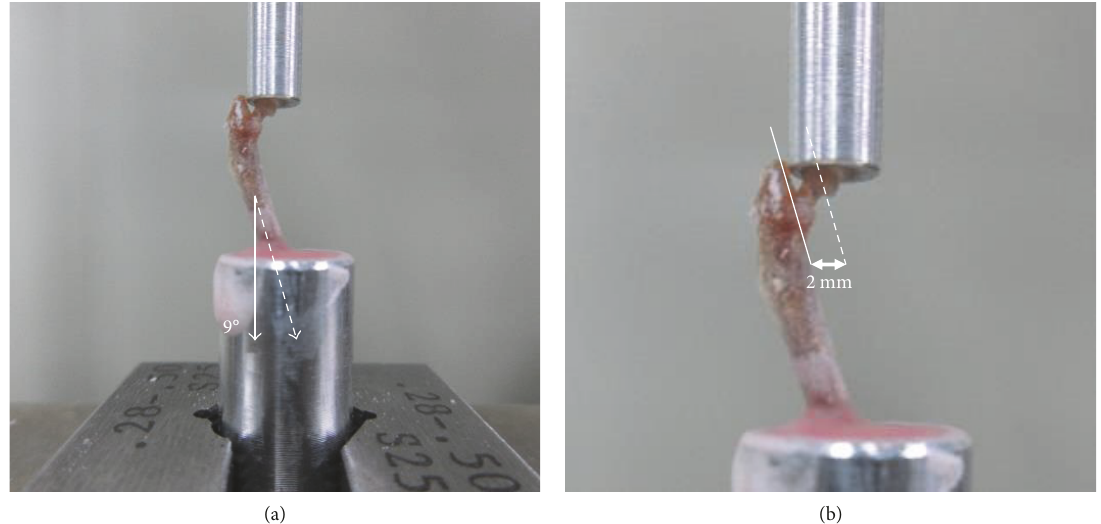
Figure 2: Setup of the femoral head compression test. (a) The femur was potted in a cylindrical lower jig at a 9 ° angle. (b) The gage length is the distance from the center point of the femoral head to the medial surface of the